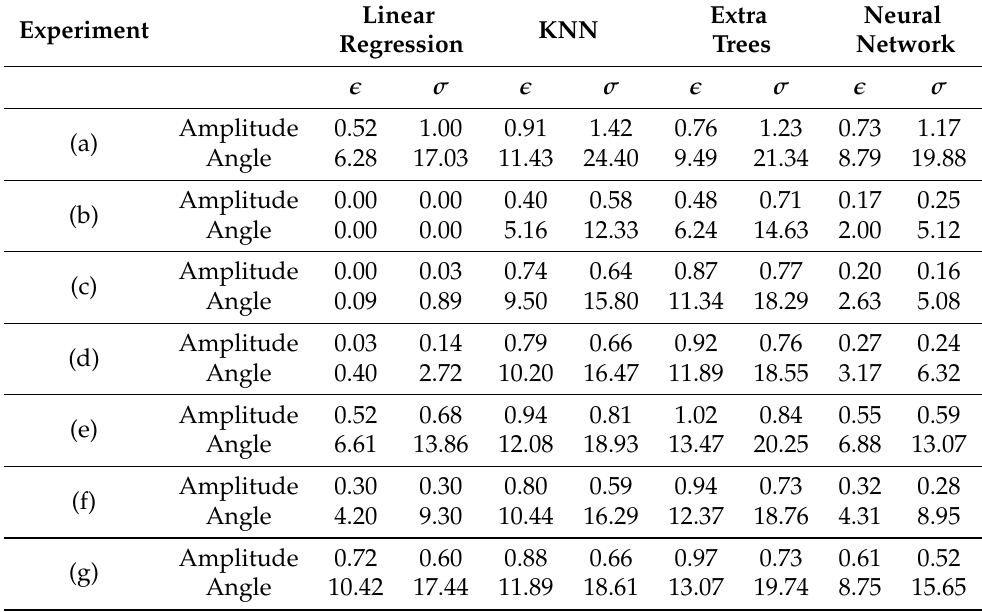
Table 2. Table containing mean reconstruction error ( (cid:101) ) and its variance ( σ ) for each of the machine learning model used in each experiment. The error is divided in amplitude and vari- ance